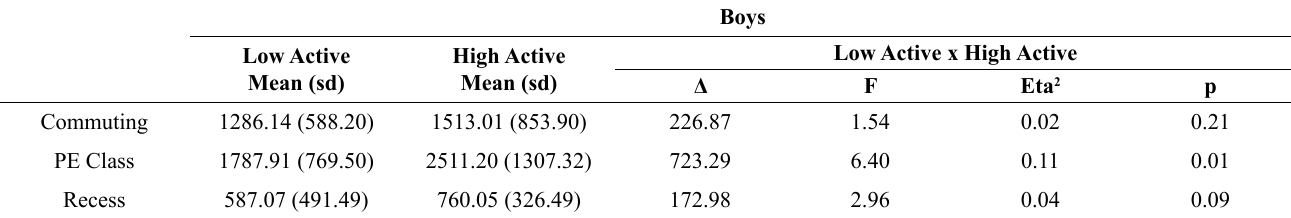
Table 2. Step counts of high active and low active adolescent boys.